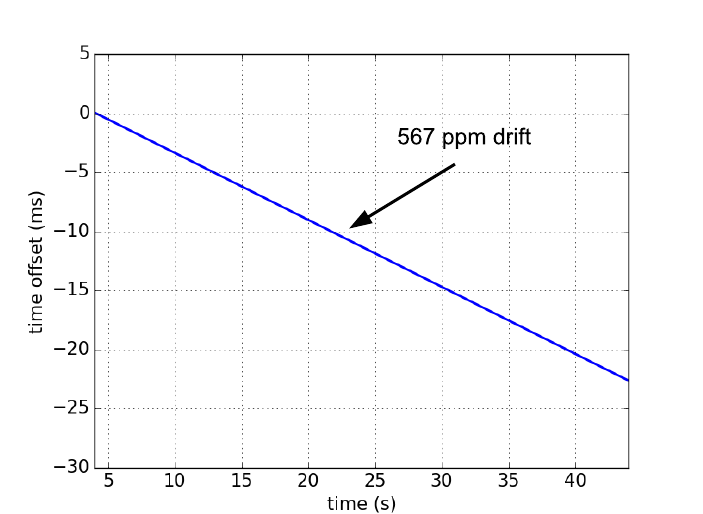
Figure 8. Time offset between free-running SCµM and OpenMote. No communication is taking place. SCµM emulates a 32 kHz clock source by dividing down the 500 kHz RFTimer source. The rounding